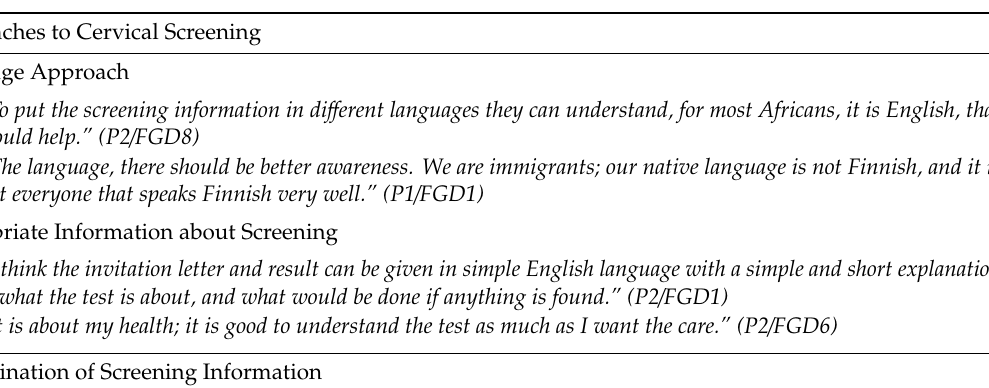
Table 5. Examples of suggestions for improving screening